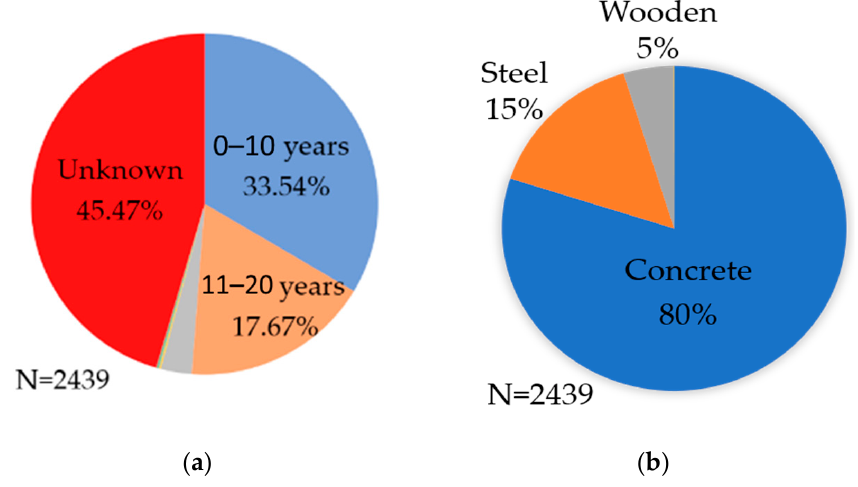
Figure 1. ( a ) Age of existing bridges; ( b ) classification based on construction material.